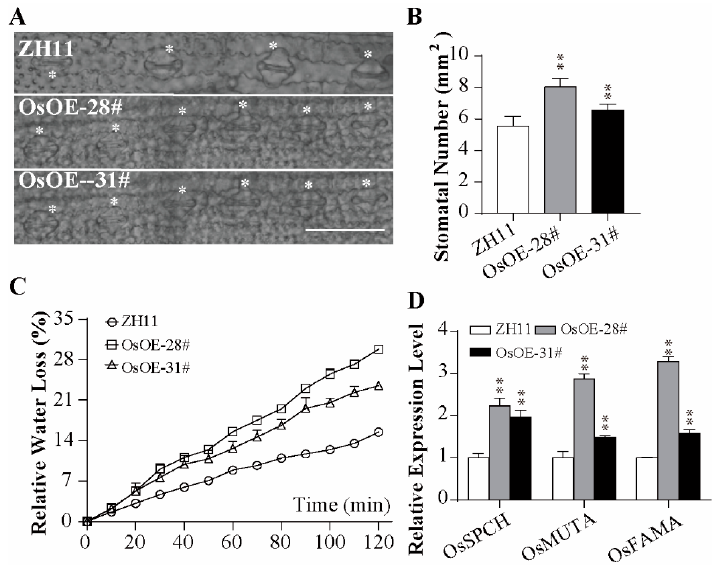
Figure 3. Characteristics of the stomatal phenotype of AcoMYB4 overexpression lines. ( A , B ) Stomatal number on the epidermis of underside of leaves at 5 leaf age of ZH11, OsOE-28#, and OsOE-31#; the error bars indicate + SD ( n = 20), Bar = 1 mm. ( C ) Relative water loss of detective leaves during a 120-min dehydration; the error bars indicate + SD ( n = 3). ( D ) Relative expression level of rice stomatal development related genes; the error bars indicate + SD ( n = 3). White “*” indicates the location of the stomata. Asterisks indicate significant differences for the indicated comparisons based on Student’s t-test (** p < 0.01; * p < 0.05).